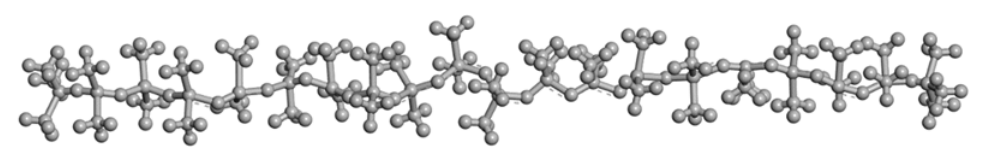
Figure 3. Molecular model diagram of dimethylsiloxane oligomer with chain number of 18. The simulation uses the DMol3 module in Materials Studio; the basis set is B3LYP, the temperature was 298 K, the electric field was 0.001 a.u., and the dipole moment was